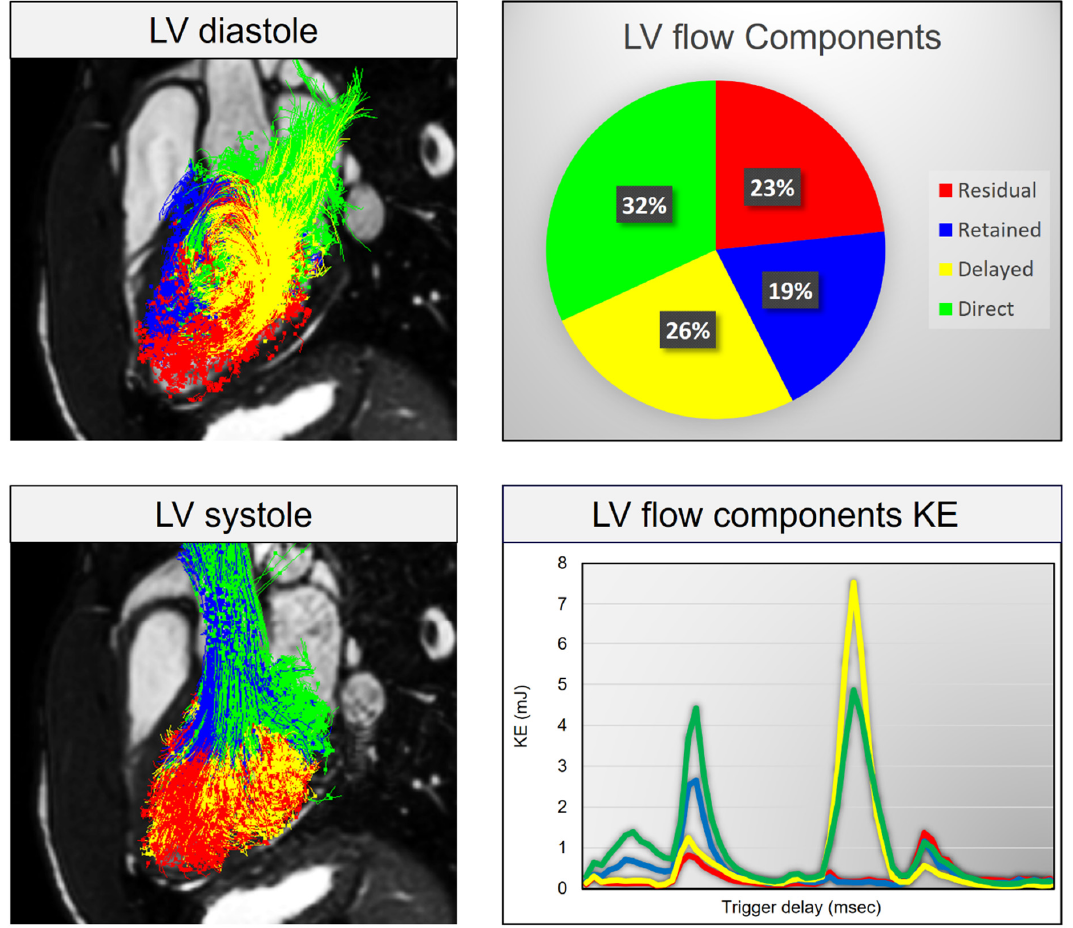
Figure 3. LV blood-flow components KE analysis. LV blood-flow component KE breakdown can give further insight into kinetic energy distribution between different flow components in various cardiovascular disorders. Red: Residual flow component, Blue: Retained flow component, Yellow: Delayed flow component, Green: Direct flow component.